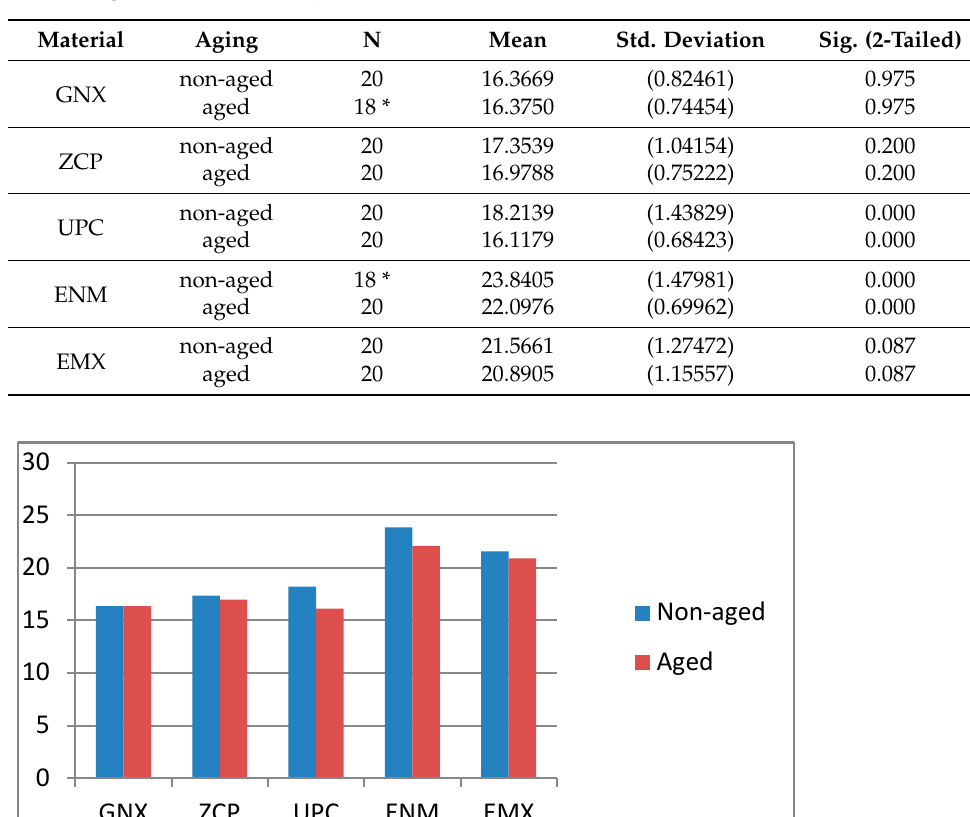
Table 9. Comparison of TP values within same material group; non-aged and aged. Shaded cells indicate significant differences p < 0.5. * Outliers were deleted.